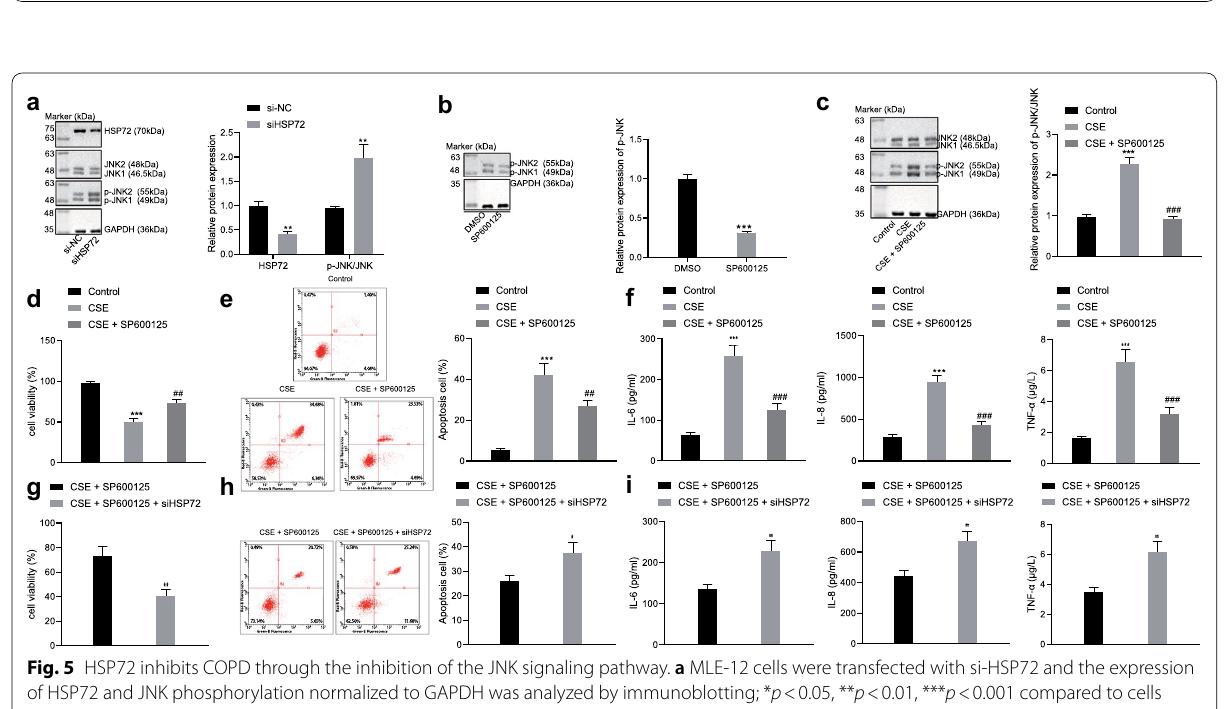
Fig. 5 HSP72 inhibits COPD through the inhibition of the JNK signaling pathway. a MLE-12 cells were transfected with si-HSP72 and the expression of HSP72 and JNK phosphorylation normalized to GAPDH was analyzed by immunoblotting; * p < 0.05, ** p < 0.01, *** p < 0.001 compared to cells transfected with si-NC. b The extent of JNK phosphorylation normalized to GAPDH after SP600125 treatment was analyzed by immunoblotting; * p < 0.05, ** p < 0.01, *** p < 0.001 compared to cells treated with DMSO. MLE-12 cells were treated with SP600125 and stimulated with CSE. c The phosphorylation of JNK normalized to GAPDH was analyzed by immunoblotting. d Cell viability was detected by CCK-8 assay. e Cell apoptosis was detected by flow cytometry. f Release of IL-6, IL-8, and TNF-α was analyzed by ELISA. * p < 0.05, ** p < 0.01, *** p < 0.001 compared to untreated cells; # p < 0.05, ## p < 0.01, ### p < 0.001 compared to cells treated with CSE. MLE-12 cells were co-treated with si-HSP72 and SP600125. g Cell viability was detected by CCK-8 assay. h Cell apoptosis was detected by flow cytometry. i Release of IL-6, IL-8, and TNF-α was analyzed by ELISA. * p <